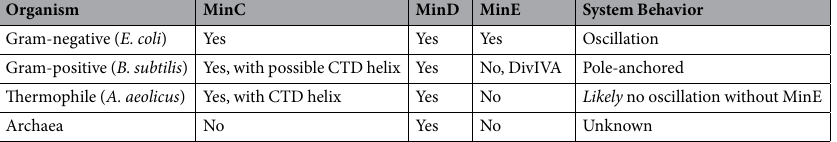
Table 2. Preliminary summary of cell division components from different organisms